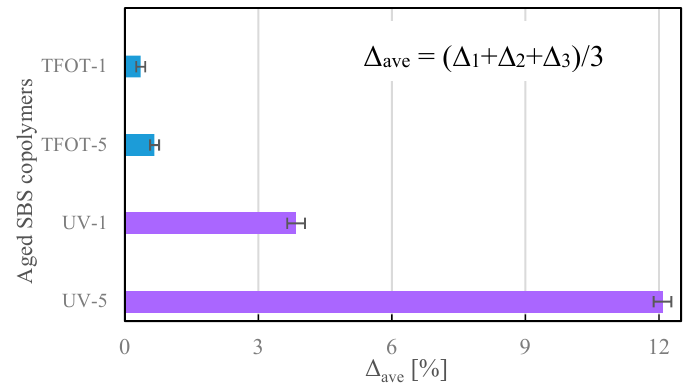
Figure 6. Average value in quality changes.